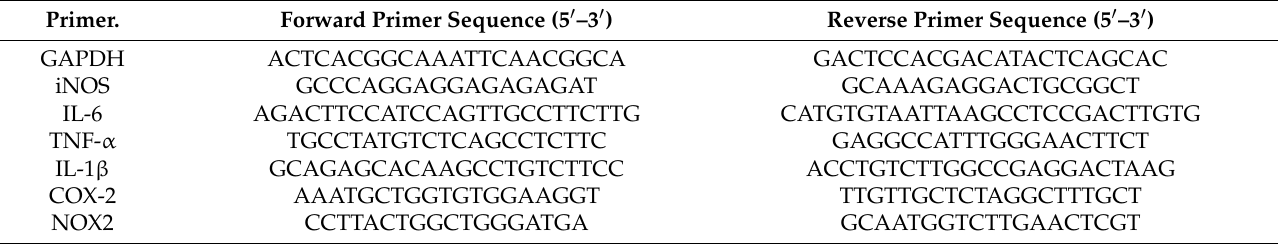
Table 3. The primer sequences for Real-time